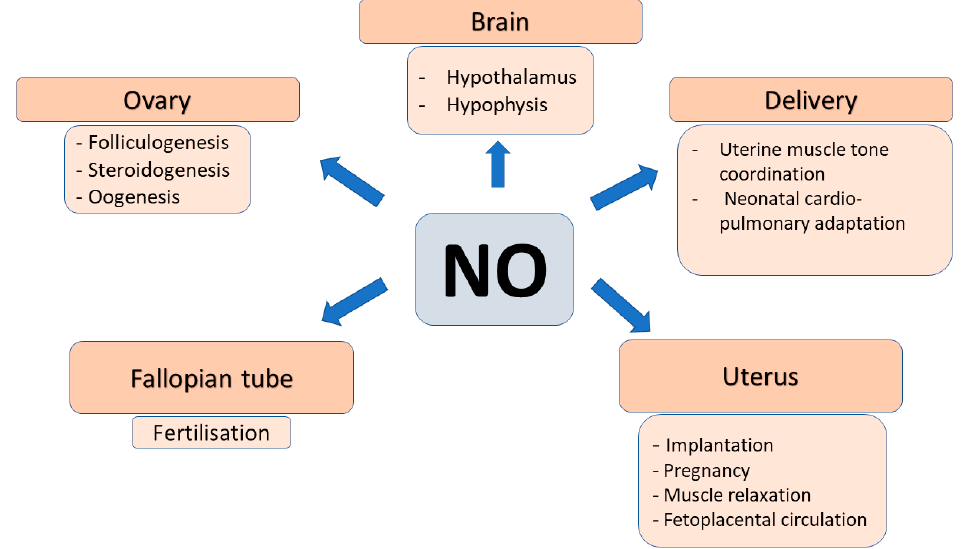
Figure 4. Summary figure for the involvement of nitrogen monoxide (NO) in the major processes of female reproduction. female